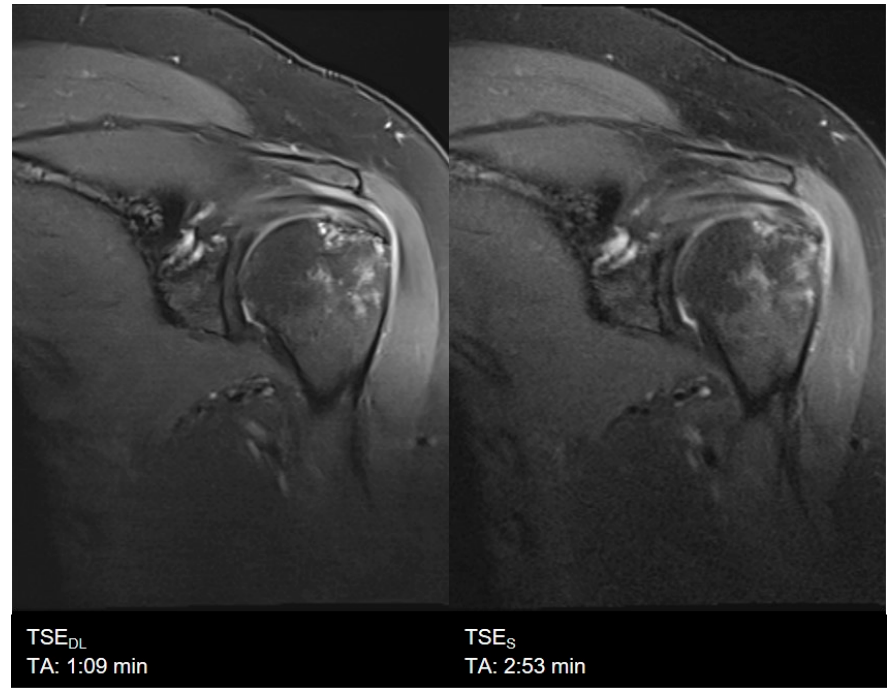
Figure 4. Example of a Deep Learning ( left ) and standard ( right ) PD-weighted turbo spin echo image of the shoulder in coronal orientation.